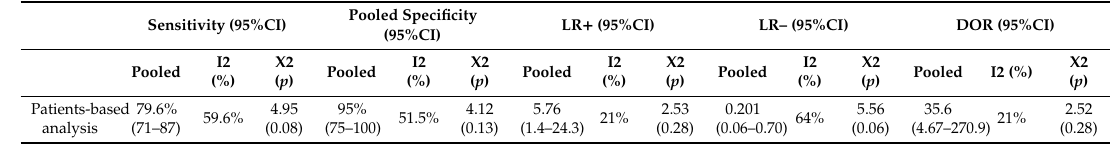
Table 3. Results from the meta-analysis.